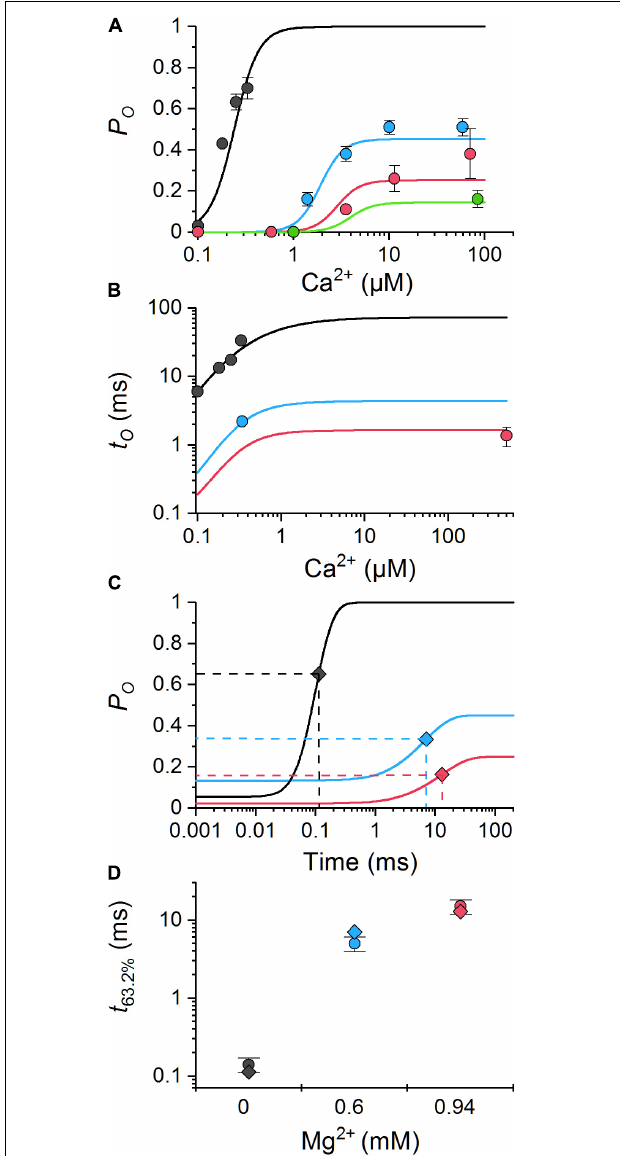
FIGURE 3 | Comparison of the MWC-Ca/Mg RyR model predictions with experimental data. The model predictions (lines) were calculated using Eqs. 14 (A) , 2 (B) , and 4 (C) and the reference set of parameter values ( Table 1 ) for the same ion conditions as the experimental data (points). (A) The calcium dependence of open probability for 0 mM Mg 2 + and 0.5 mM total ATP (Tencerova et al., 2012) (black), and for 0.6, 0.94, and 1.33 mM free Mg 2 + (blue, red, and green, respectively) and 3 mM total ATP (Zahradnikova et al., 2003). (B) The calcium dependence of mean open time for 0 mM total Mg 2 + and 0.5 mM ATP (Tencerova et al., 2012) (black), for 0.6 mM free Mg 2 + , 3 mM total ATP (Zahradnikova et al., 2003) (blue), and for 1 mM free Mg 2 + and 2 mM total ATP (Cannell et al., 2013) (red). (C) The simulated time course of RyR responses to a step Ca 2 + increase from 100 nM to 20 µ M in the absence of Mg 2 + (black), and from 1.5 to 10 µ M Ca 2 + in the presence of 0.6 and 0.94 mM free Mg 2 + and 3 mM total ATP (blue and red lines, respectively). The 63.2% activation time is indicated by diamonds. (D) Comparison of the calculated (diamonds) and experimental (dots with error bars) 63.2% activation times obtained under conditions shown in panel (C) ; black - (Zahradnikova et al., 1999), red and blue - (Zahradnikova et al.,